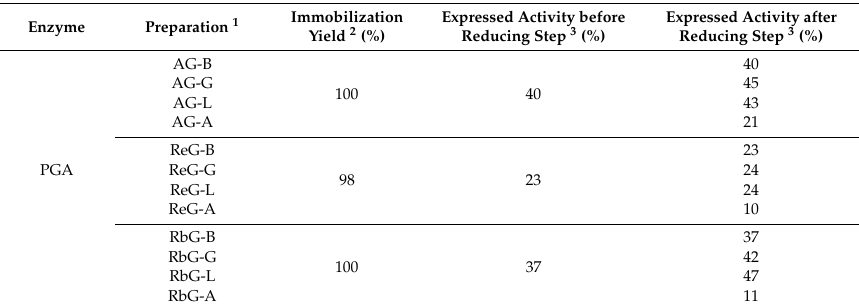
Table 2. Immobilization summary for PGA on di ff erent supports and blocking